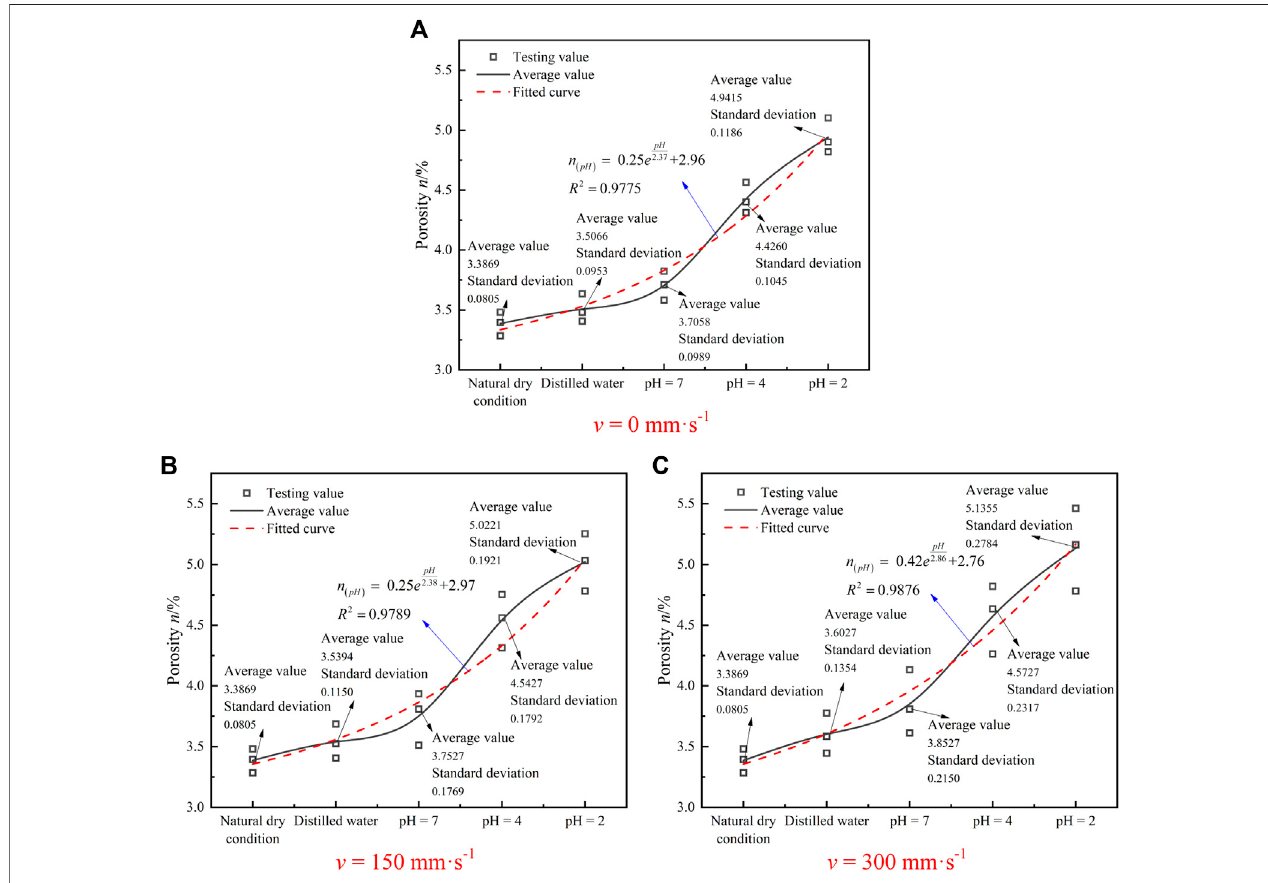
FIGURE 6 | Porosity change diagram of granite samples under different fl ow rates of acid solution. (A) v = 0 mm · s -1 . (B) v = 150 mm · s -1 . (C) v = 300 mm · s -1 .